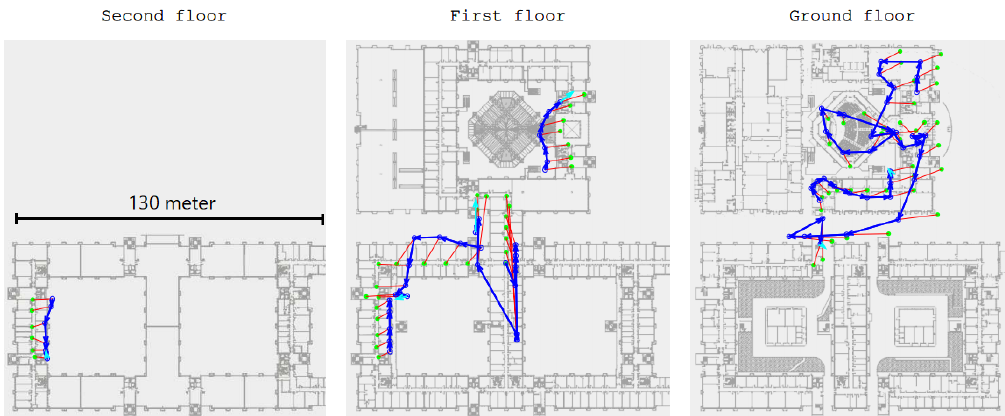
Figure 19. ( Left ): s floor. ( Center ): First floor. ( Right ): Ground floor. Green dots are the ground truth, blue dots are the STEPS system report, and red lines are the report’s error